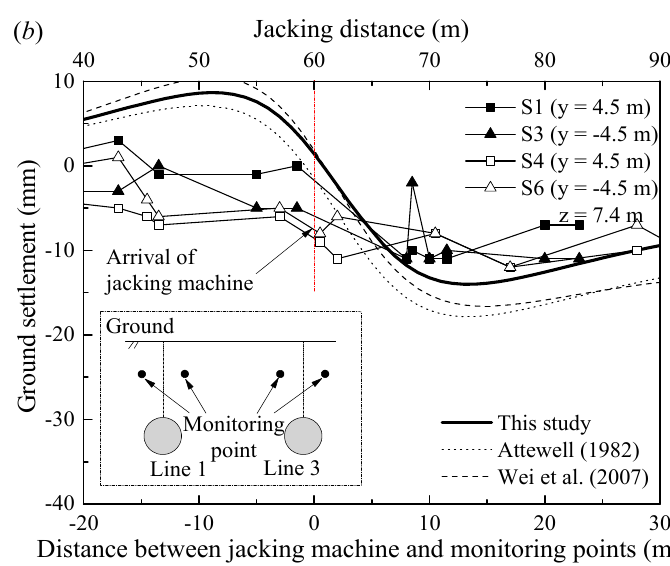
Figure 14. Ground settlements at both sides of pipe-jacking at different depth: ( a ) 4.4 m, ( b ) 7.4 m.